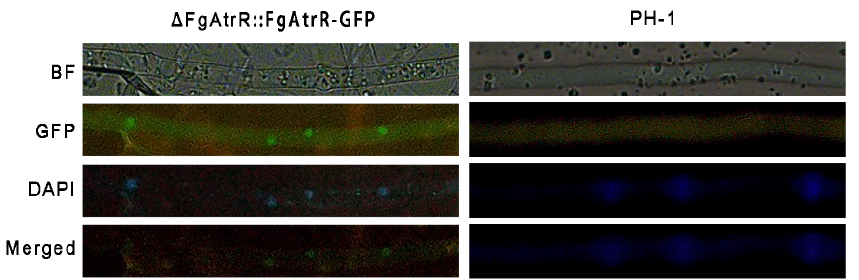
Figure 6. Subcellular localization of FgAtrR-GFP in Fusarium graminearum . Nuclei were stained with DAPI. The GFP and DAPI signals were examined under a fluorescence microscope. BF, bright field.